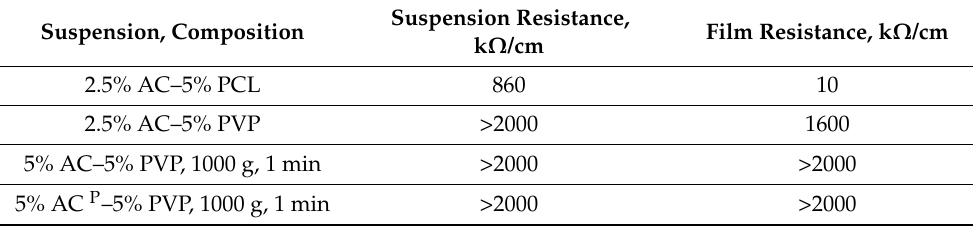
Table 3. Electrical resistance of AC suspensions and cast films made from them.